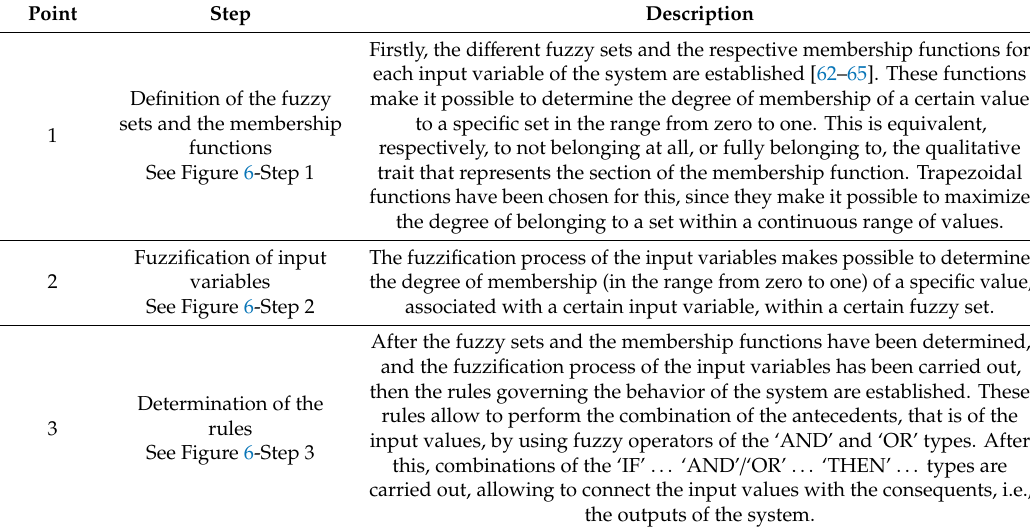
Figure 6. Diagram of the Technical Risk inference system operation. Table 2. Description of the operation of the inference system used to calculate the Technical